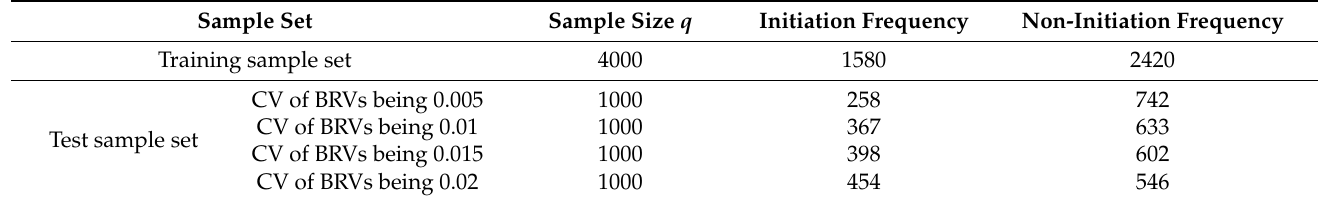
Table 9. The statistical results of the initiation and non-initiation frequencies of Composition B in the training sample set and test sample sets under the shock load condition where v is 1000 m/s.